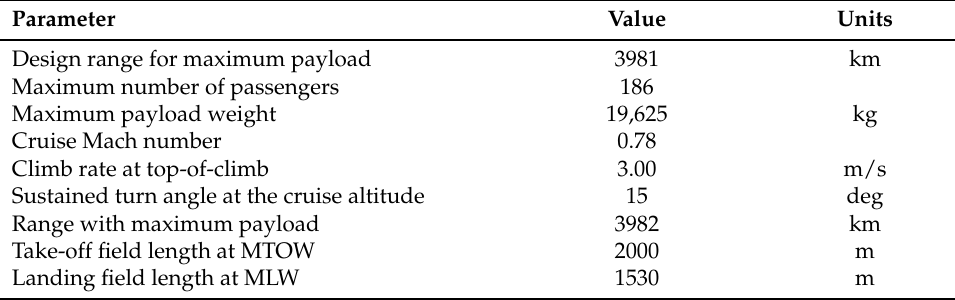
Table 1. SE 2 A Midrange aircraft top-level requirements (adapted from